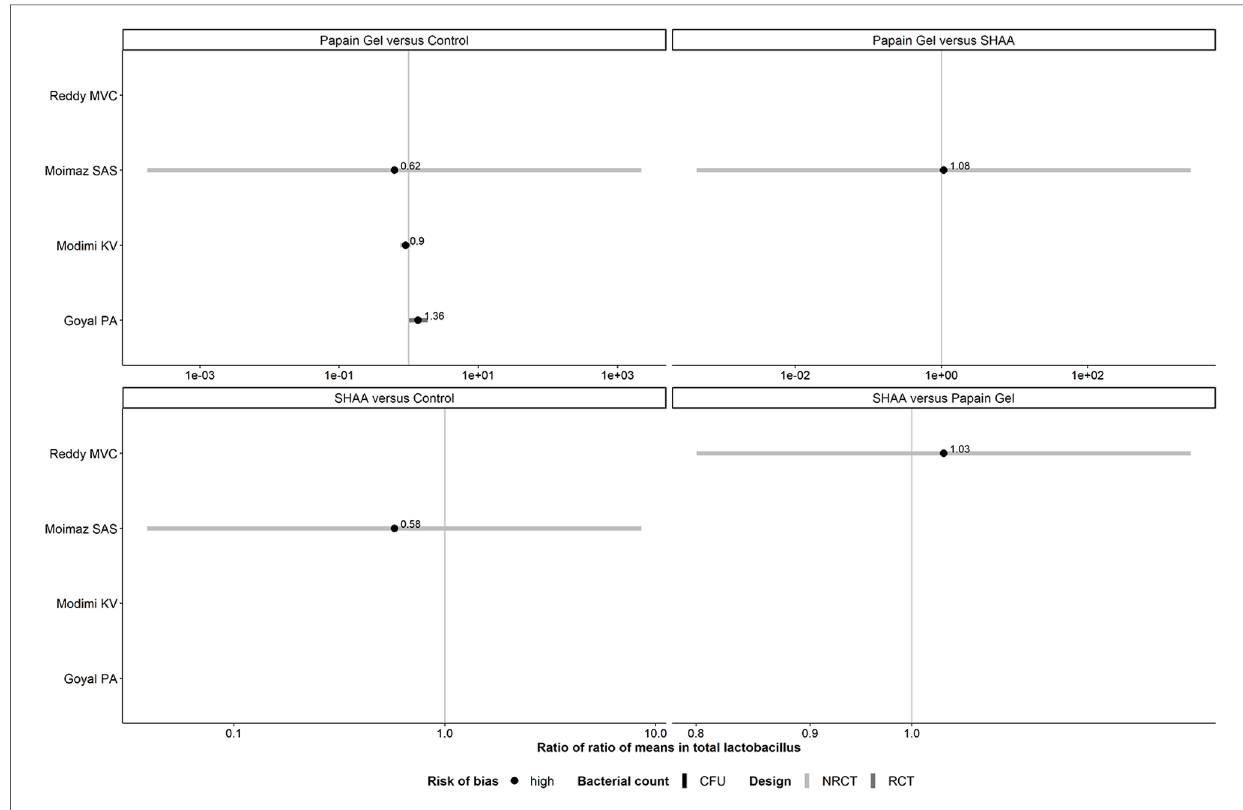
FIGURE 6 Forest plots showing roRoMs for Lactobacillus across chemomechanical